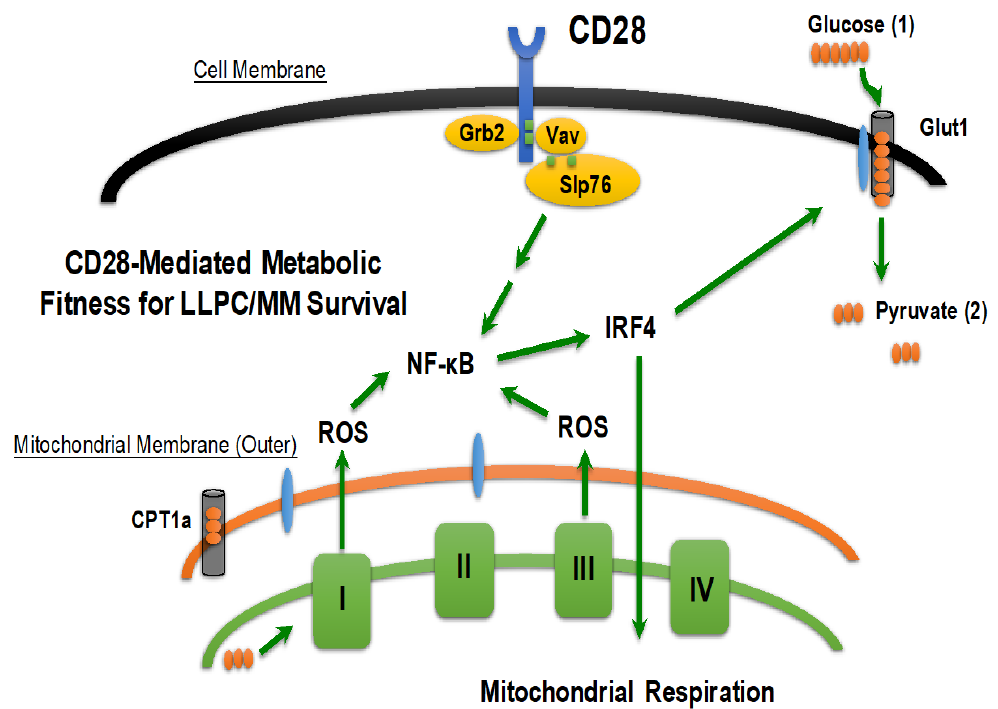
Figure 3. Model of CD28-mediated metabolic fitness in LLPC. CD28, through Grb2 / Vav / SLP-76 signaling in LLPC, induces NF- κ B activation. NF- κ B is a known transcriptional regulator of IRF4, which is a transcription factor required for LLPC survival. CD28 activation increases IRF4 expression, which increases LLPC glucose uptake, mitochondrial mass, and mitochondrial respiration. One byproduct of mitochondrial respiration is the production of reactive oxygen species, which go on to facilitate further NF- κ B activation for IRF4-mediated metabolic fitness and LLPC